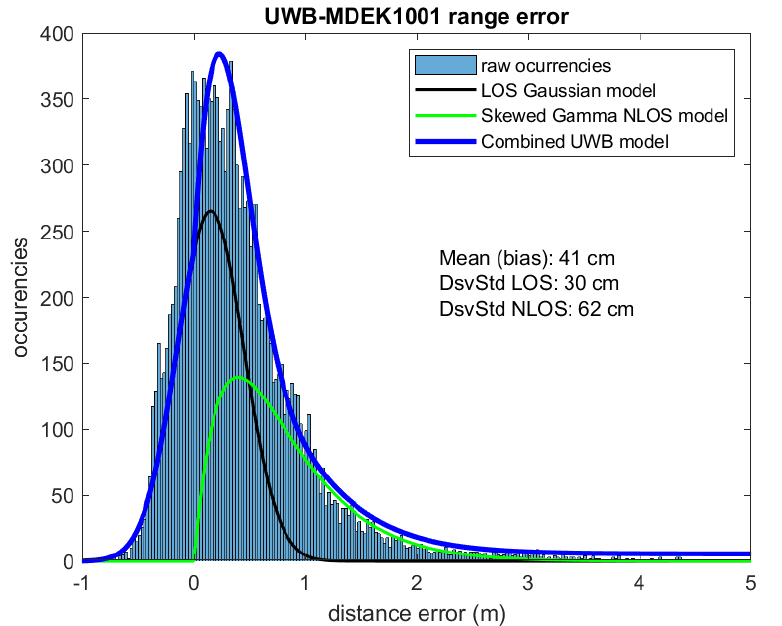
Figure 20. Error distribution in ranging (tags to anchors) at the apartment scenario An NLOS model (blue) is overlaid on the experimental